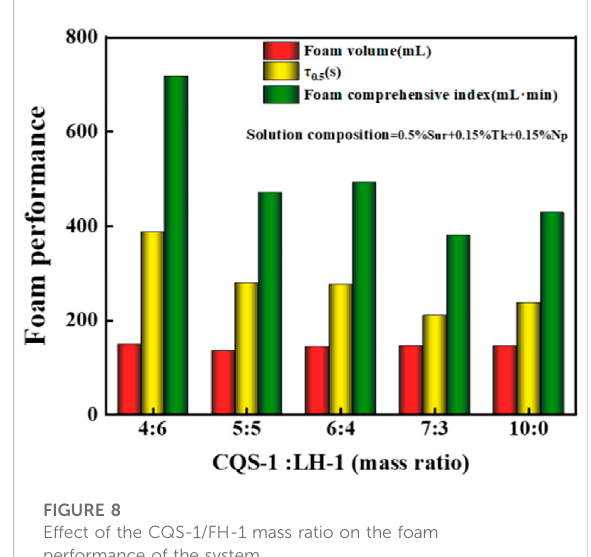
Effect of the CQS-1/FH-1 mass ratio on the foam performance of the system.